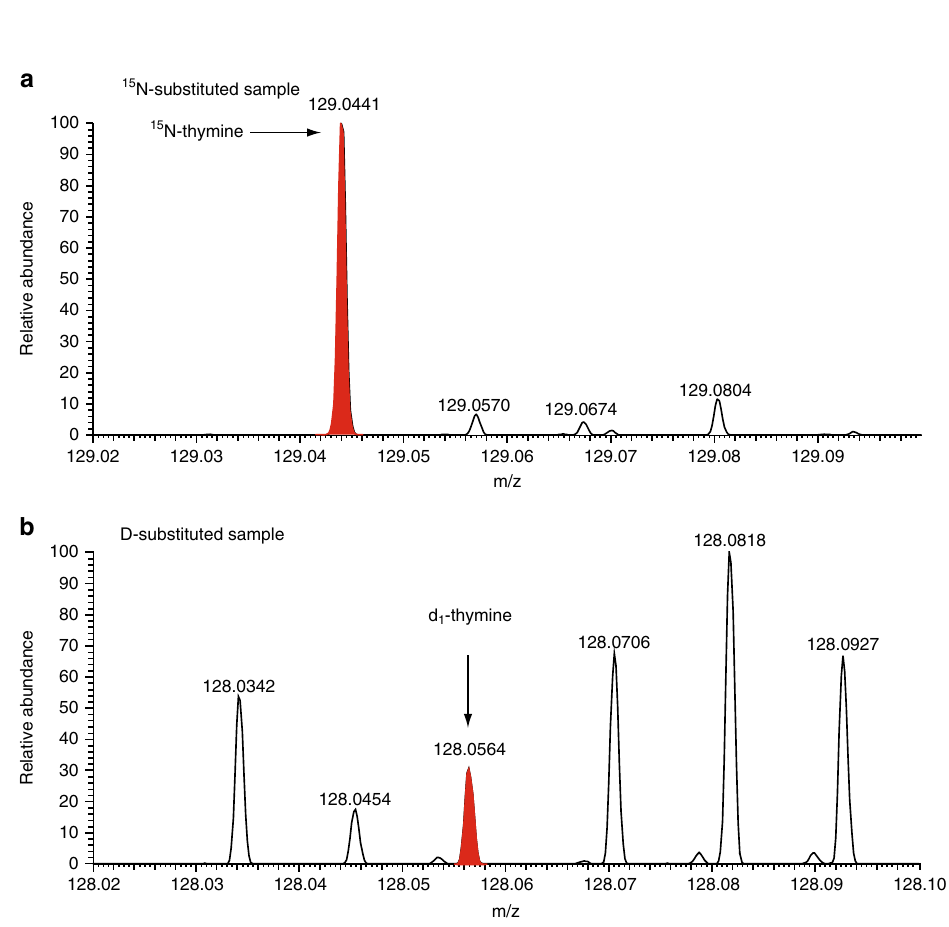
Fig. 4 Identi fi cation of thymine in the isotopically labelled organic residues. Mass spectra of thymine observed in the a 15 N- and b D-substituted samples at m / z from 129.02 to 129.1 and from 128.02 to 128.10, respectively. Red coloured peaks at the m / z of 129.0441 in panel ( a ) and at the m / z of 128.0564 in panel ( b ) correspond to the 15 N-substituted ( 15 N – ) thymine (C 5 H 6 15 N 2 O 2 : the m / z of the protonated ion is 129.0443) and the singly deuterated (d 1 – ) thymine (C 5 H 5 DN 2 O 2 : the m / z of the protonated ion is 128.0565), respectively. Please see the Methods section and the Supplementary Figs. 21 – 29 for further details on the 15 N- and D-isotope probing